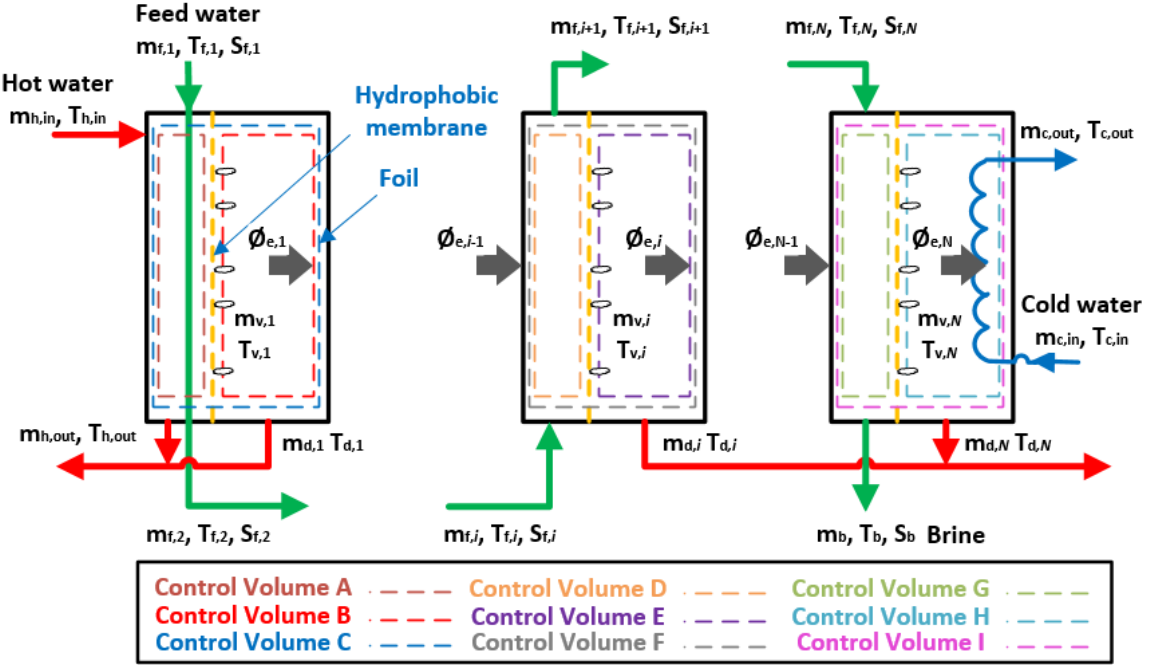
Figure 3. Simplified schematic diagram and control volumes of the V-MEMD system including the stream raiser, a typical effect, and the condenser.